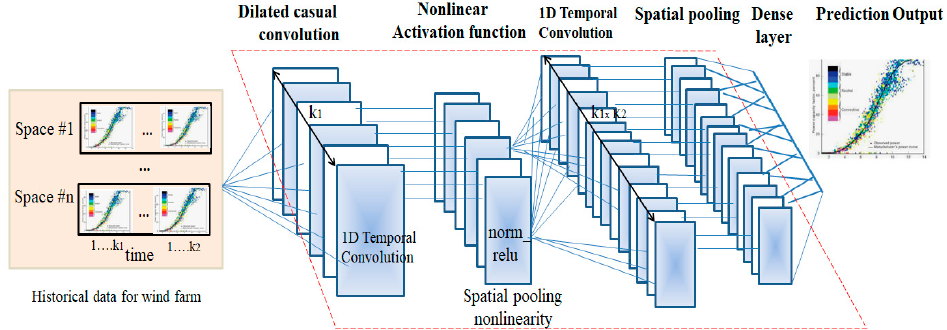
Figure 1. Basic architecture of a temporal convolutional network for wind power